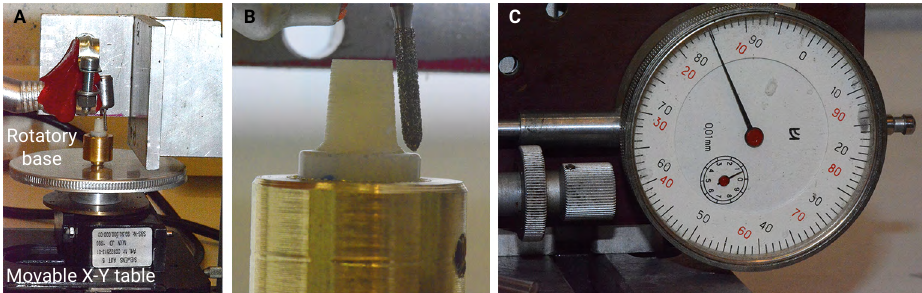
Figure 2. A. Special device for grinding the composite preparations. B. Composite core after grinding (bur positioned parallel to the composite surface). C. Micrometer installed onto a movable X-Y table to standardize the grinding